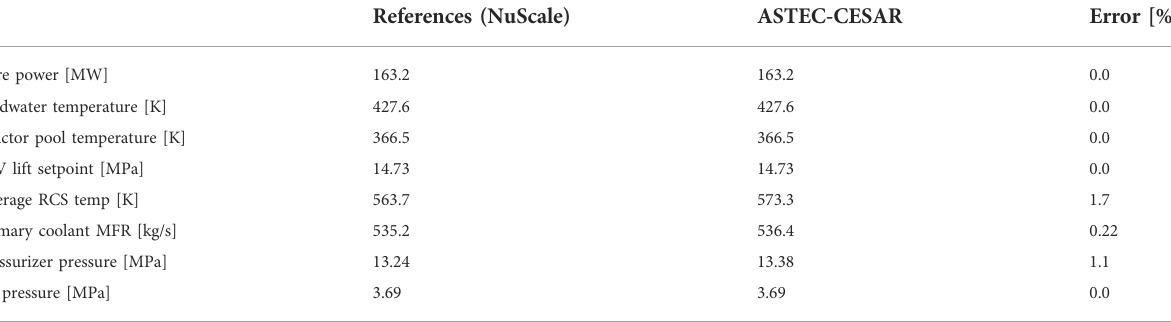
TABLE5Formlosscoef fi cients,secondaryfeedwaterMFRandSGheat exchange area used in the conservative steady state from which the transient will be simulated. *The reference feedwater MFR here is not provided by NuScale but increased by 2% from the steady-state value of 67.07 kg/s, scaled linearly with the higher input